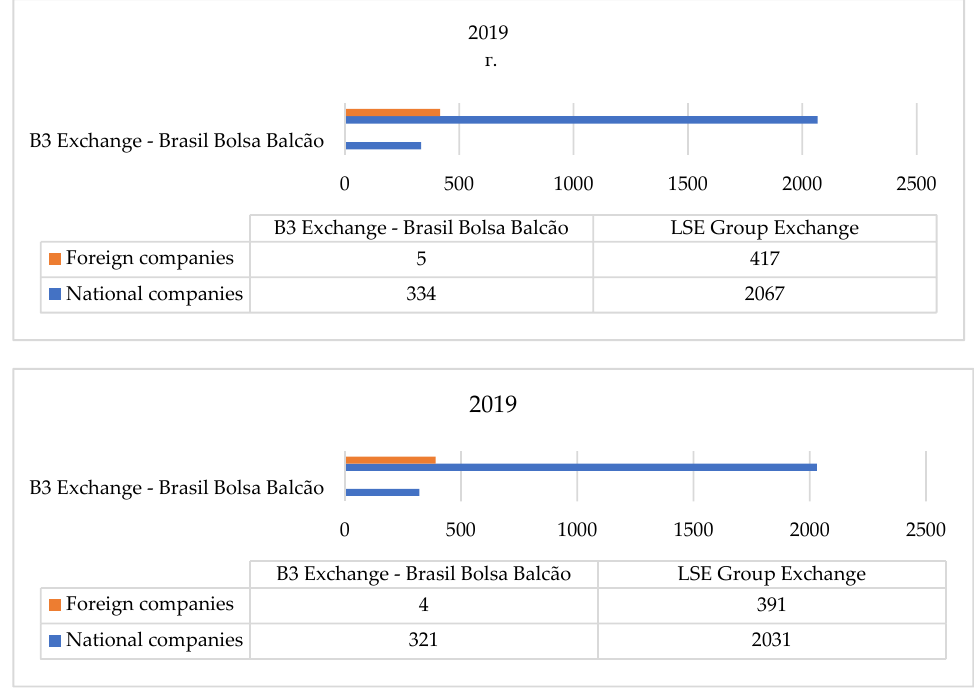
Figure 4. Comparison of the capitalization volumes of the main stock markets of the UK and Brazil for 2018–2019. Formed by the authors on the basis of The World Federation of Exchanges (2018), The World Federation of Exchanges (2019). Let us consider the number of companies listed on the stock exchanges (Figure 5).